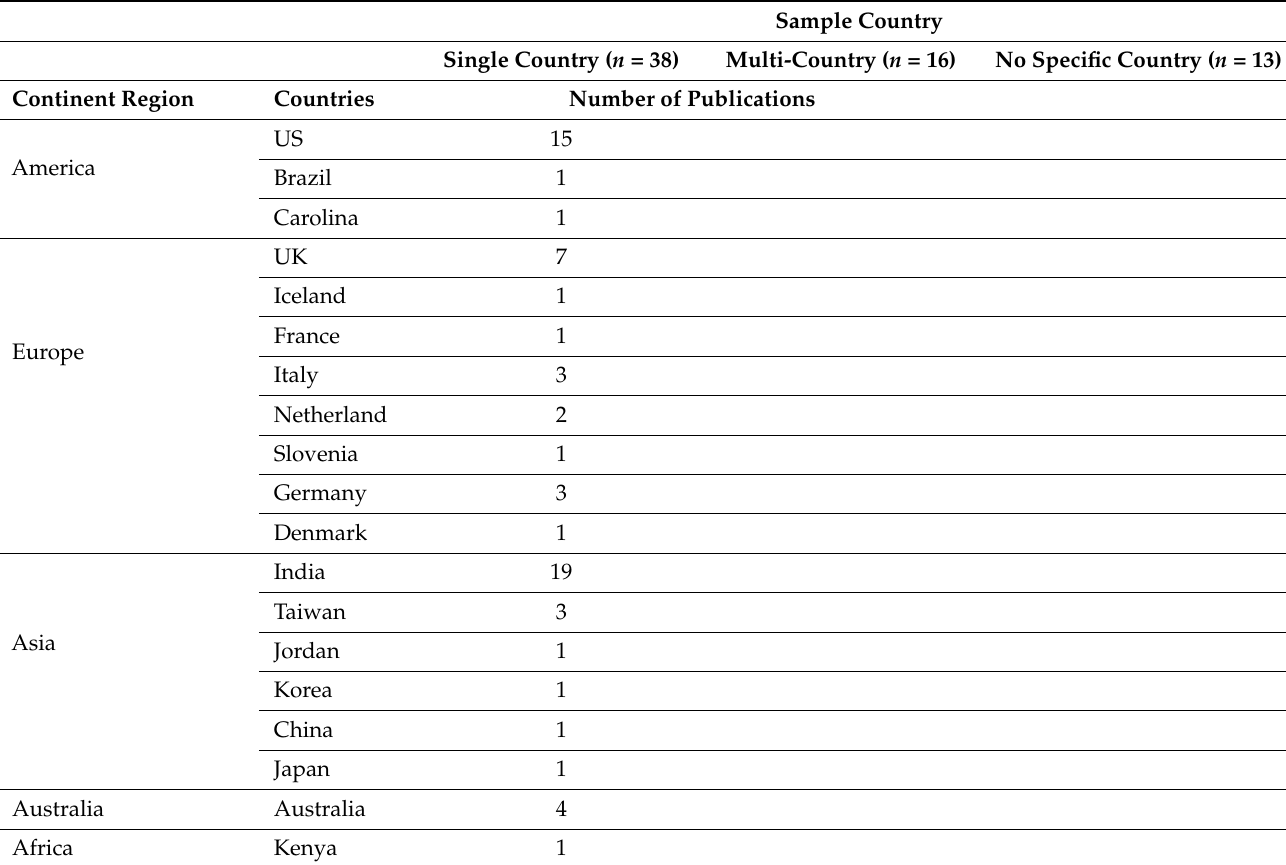
Table 4. Sample Country, Source: The Authors.